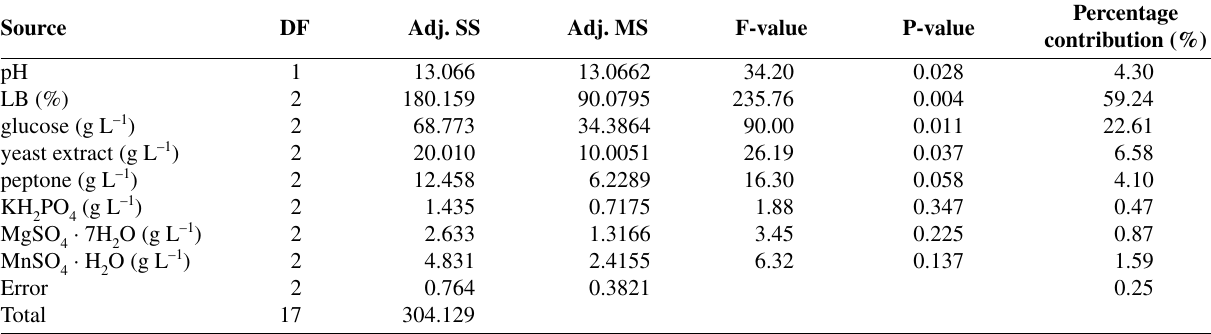
Table 4: Analysis of variance means (ANOVA)